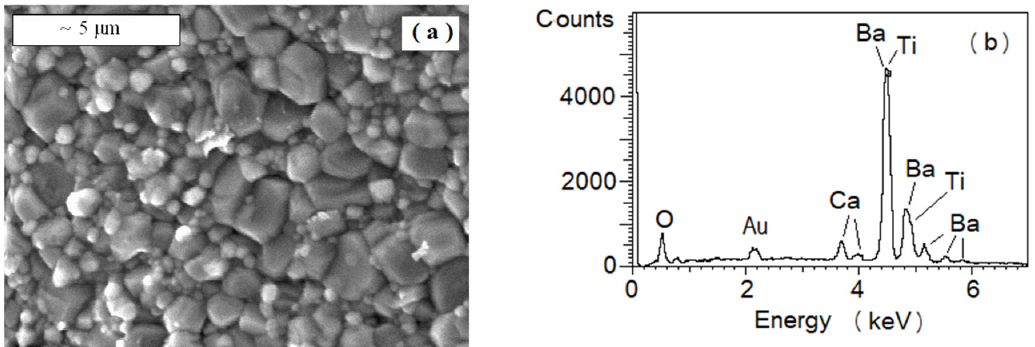
Figure 2. ( a ) SEM map obtained for BCT ceramics (magnification: 10,000). ( b ) Survey spectrum of BCT ceramics.